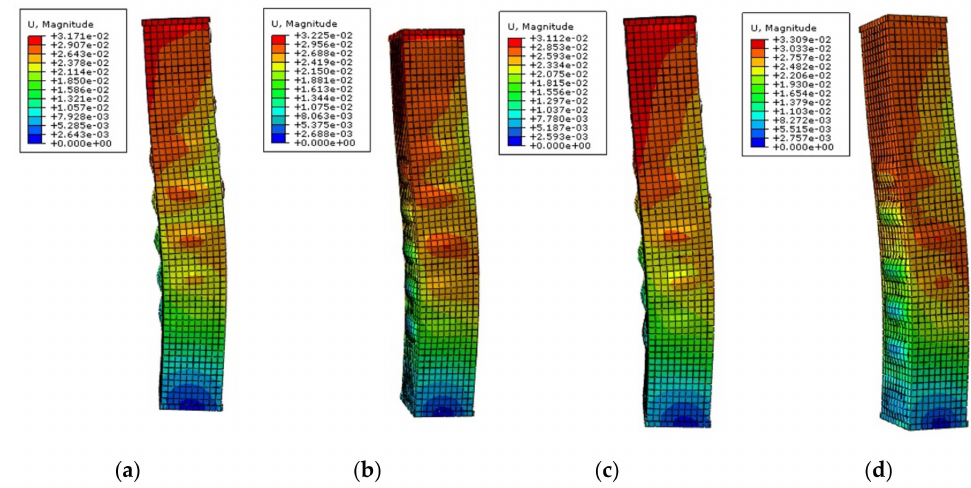
Figure 8. Contour of deflection for the SCSFT column with ( a ) 1 mm, ( b ) 2 mm, ( c ) 3 mm, and ( d ) 4 mm cross-shaped plates.